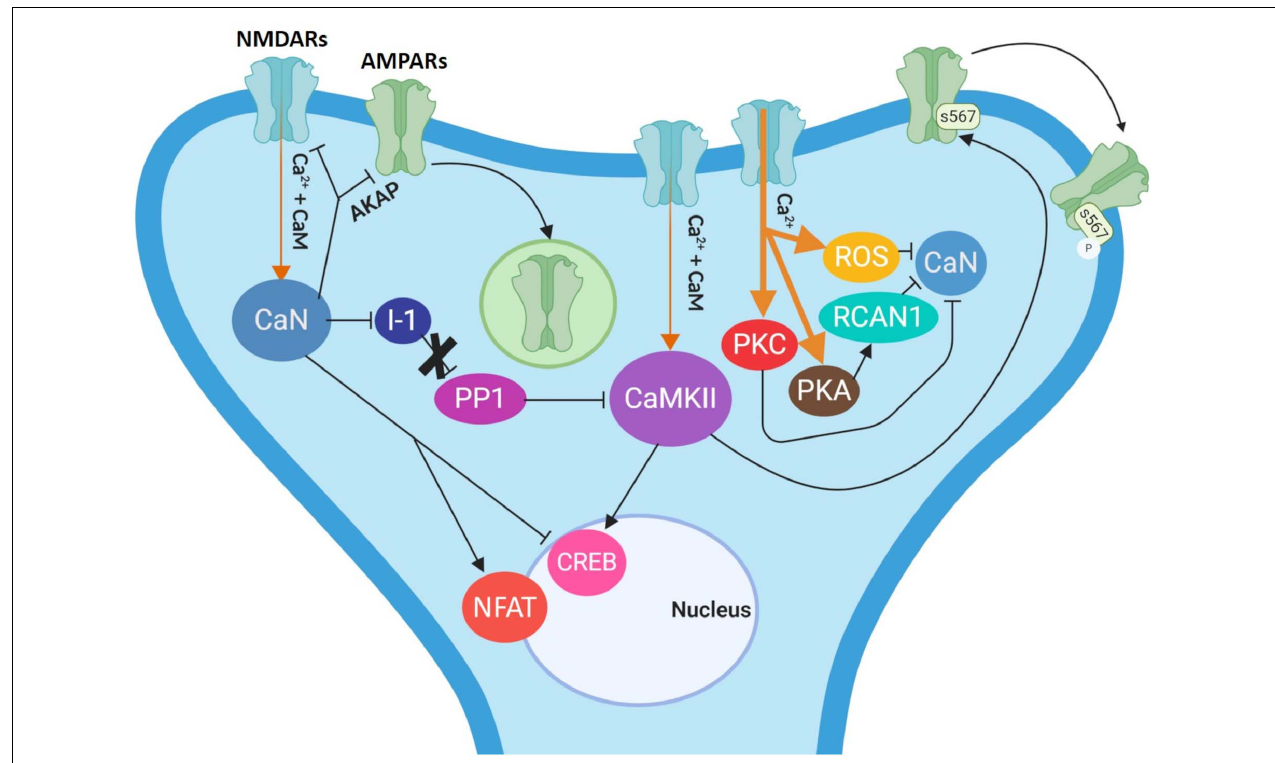
FIGURE 3 | Molecular modulation of extinction. In low concentrations (thin orange arrows), the Ca 2 + /calmodulin complex activates CaN, which then dephosphorylates the I-1 (inhibitor 1), allowing PP1 to dephosphorylate CaMKII. CaN also dephosphorylates NMDARs (in blue) and AMPARs (in green) through AKAPs leading to AMPARs endocytosis, thus promoting LTD induction. NMDAR stimulation that induce LTD may also activate CaMKII, which elicits the phosphorylation of the AMPARs at residue S567 of the GluA1 subunit, propitiating their removal to the extra-synaptic space. CaN dephosphorylates CREB and the NFAT transcription factors as well. High concentrations of Ca 2 + (thick orange arrows) activate kinases such as PKC and PKA, ROS and RCAN1 may act as CaN endogenous inhibitors. Arrows indicate activation while T arrows indicate inhibition either by phosphorylation or dephosphorylation. I-1: inhibitor 1; PP1: protein phosphatase 1; NFAT: nuclear factor of activated T-cells; CREB: cAMP response element binding; AKAP: A-Kinase Anchoring Protein; ROS: reactive oxygen species; PKA: protein kinase A; PKC: protein kinase